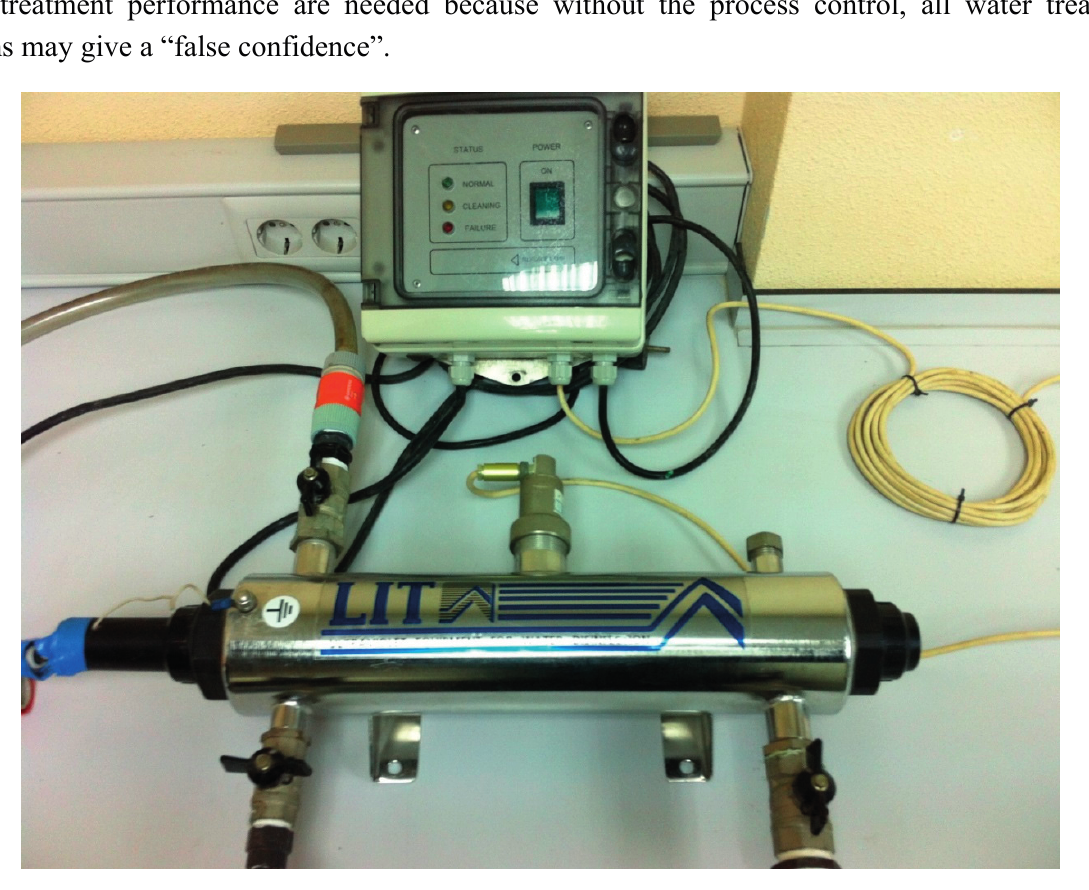
Figure 2. UV-C treatment system where water passes through a vessel while it is illuminated by UV-C lamps located in the vessel. Reprinted with permission of Quality and Safety Lab